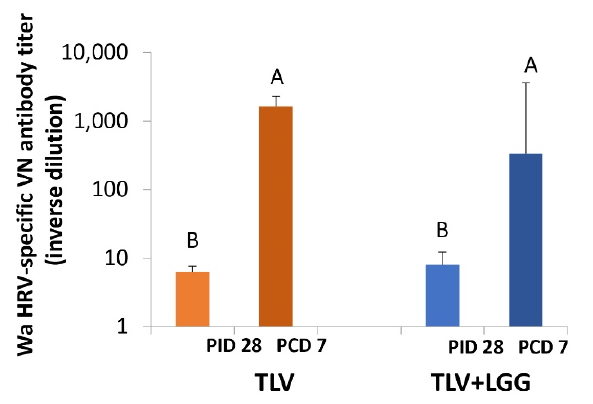
Figure 8. Virus neutralizing antibody responses to Wa HRV pre- and postchallenge in TLV and TLV+LGG groups. Bars with different uppercase letters (A, B) differs significantly. Antibody titers between the two groups on each timepoint were not significantly different. VN antibody titers of both groups increased significantly postchallenge (repeated measure ANOVA-GLM, p < 0.05).